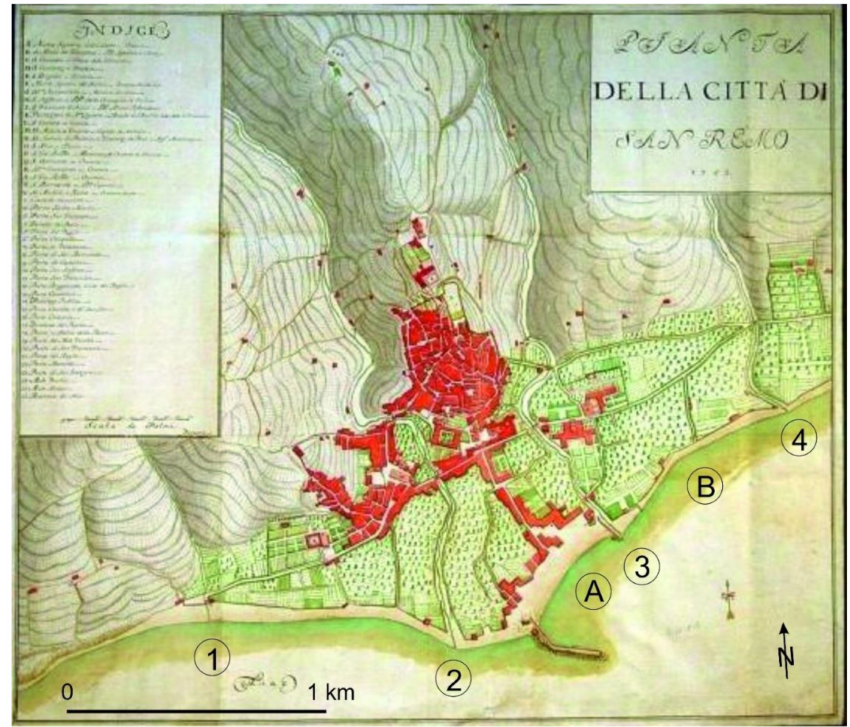
Figure 2. Historical map of Sanremo coast (1753): ( 1 ) Mafalda, ( 2 ) San Romolo, ( 3 ) San Francesco, ( 4 ) San Lazzaro streams; ( A ) and ( B ) represent the current locations of Porto Vecchio and Portosole, respectively (modified after [52]).